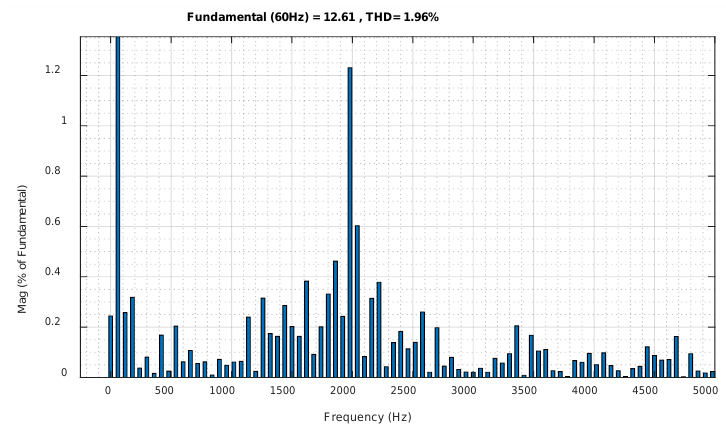
Figure 12. Load current THD spectrum using the proposed method.